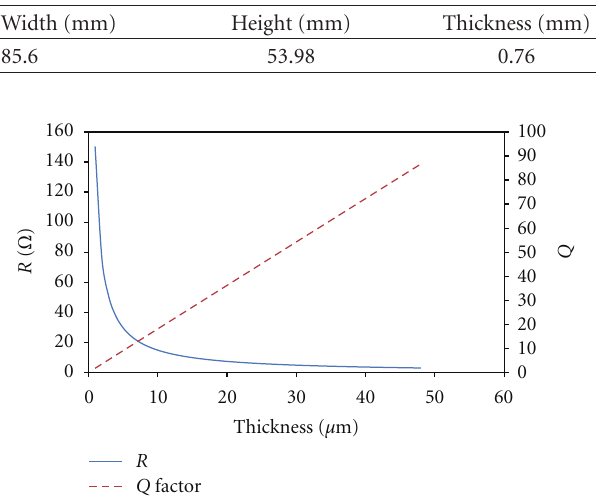
Figure 7: Calculation of R and Q for di ff erent thickness. Table 3: Obtained results of the two prototypes: analytical (A), simulation (S), and measured (M).